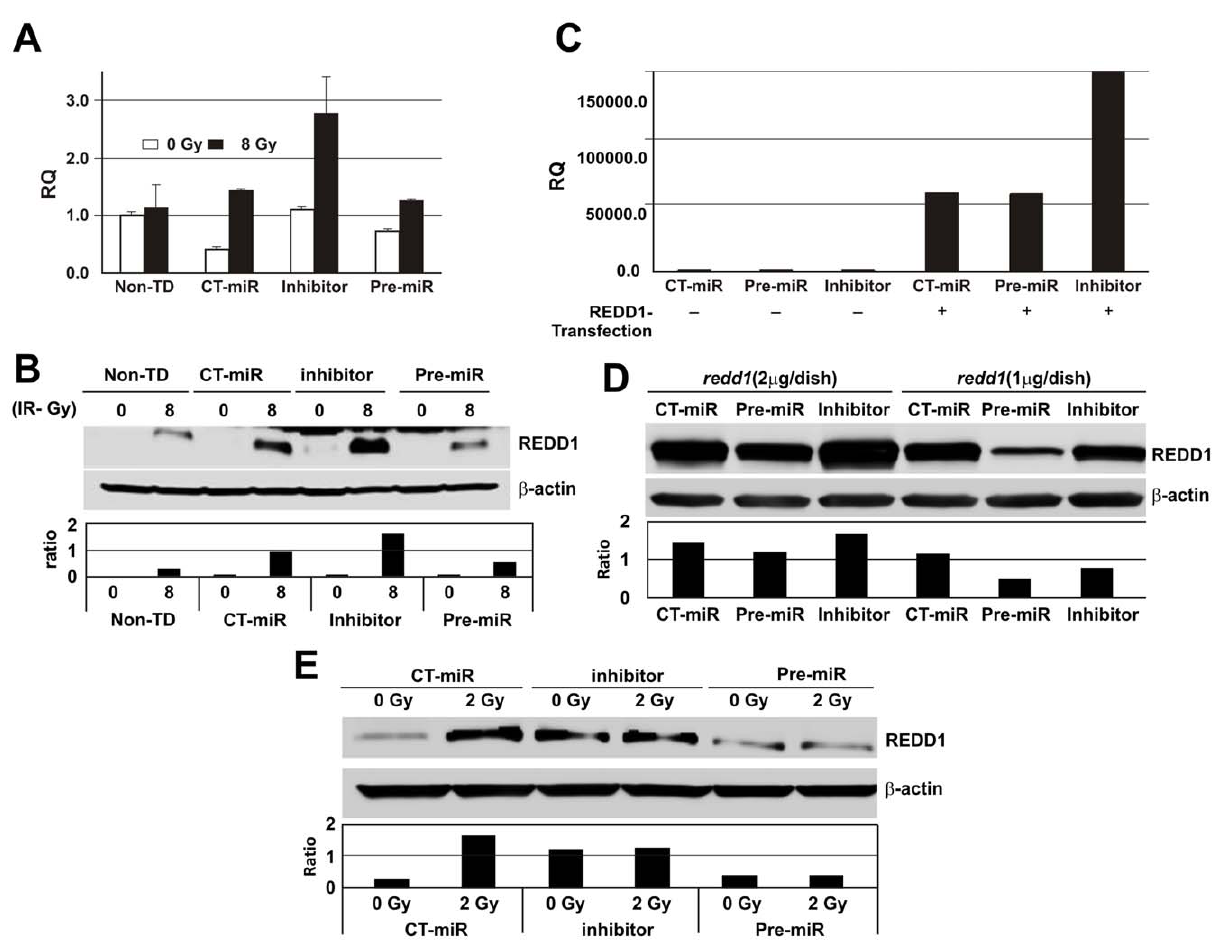
Figure 5. hsa-miR30c regulates REDD1 gene and protein expression in hFOB and CD34 + cells after c -irradiation. Endogenous REDD1 gene (A) and protein (B) levels were measured after pre-miR30c, miR30c-inhibitor, or control-miR (CT-miR) transfection and c -irradiation in hFOB cells. Transfection of miR30c-inhibitor upregulated REDD1 gene and protein levels in irradiated samples, whereas radiation-induced REDD1 expression was inhibited by pre-miR30c compared with control-miR transfected sample determined by western blot assays. pre-miR30c, miR30c-inhibitor, or control- miR was co-transfected with either PCMV6-AC-GFP-REDD1 plasmid DNA (1 m g or 2 m g /dish) or vector control. REDD1 gene (C) and protein (D) expression were determined at 24 h post-transfection. Effects of miR30c on REDD1-overexpressing cells are shown. (E) REDD1 protein levels were measured by western blot assays after pre-miR30c, miR30c inhibitor, or control miR (CT-miR) transfection and c -irradiation in 14 day cultured CD34 + cells (differentiated cells). Radiation-induced REDD1 expression was inhibited by pre-miR30 transfection. Representative expression from 3 independent experiments is shown. Non-TD: miRNA-untransfected control.